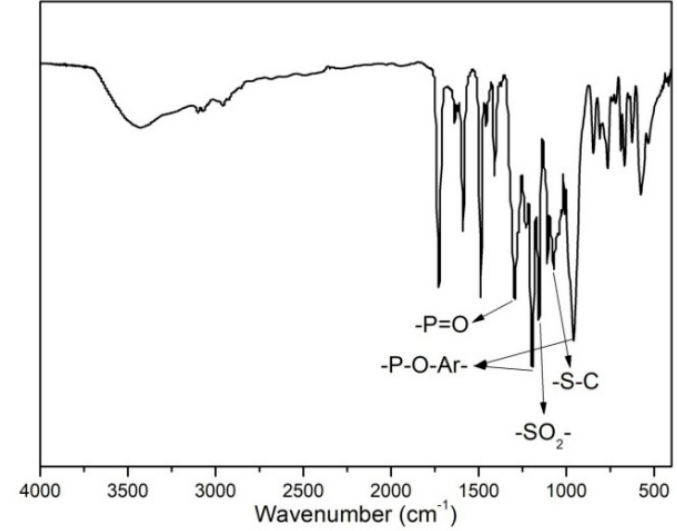
Figure 2. FTIR spectrum of BADPS.